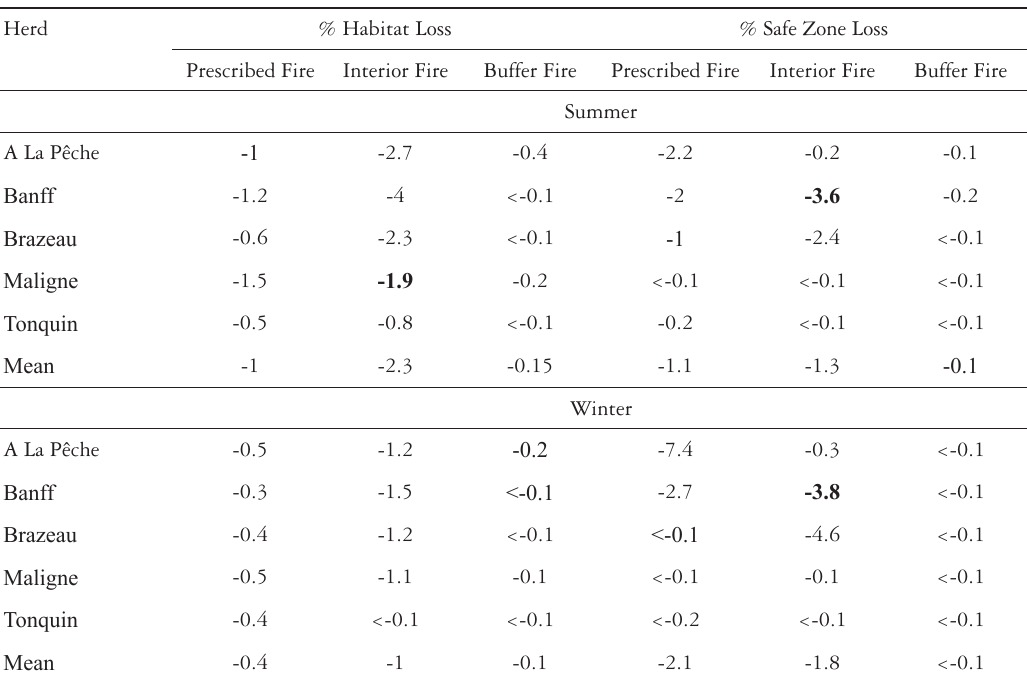
Table 3. Percentage areal reduction (%) in habitat quality and amount of safe zone by herd following simulated 1% prescribed, within home range, and within buffer zone fires. Values greater than equal losses to the 1% fire are bolded, indicating indirect effects of fire were